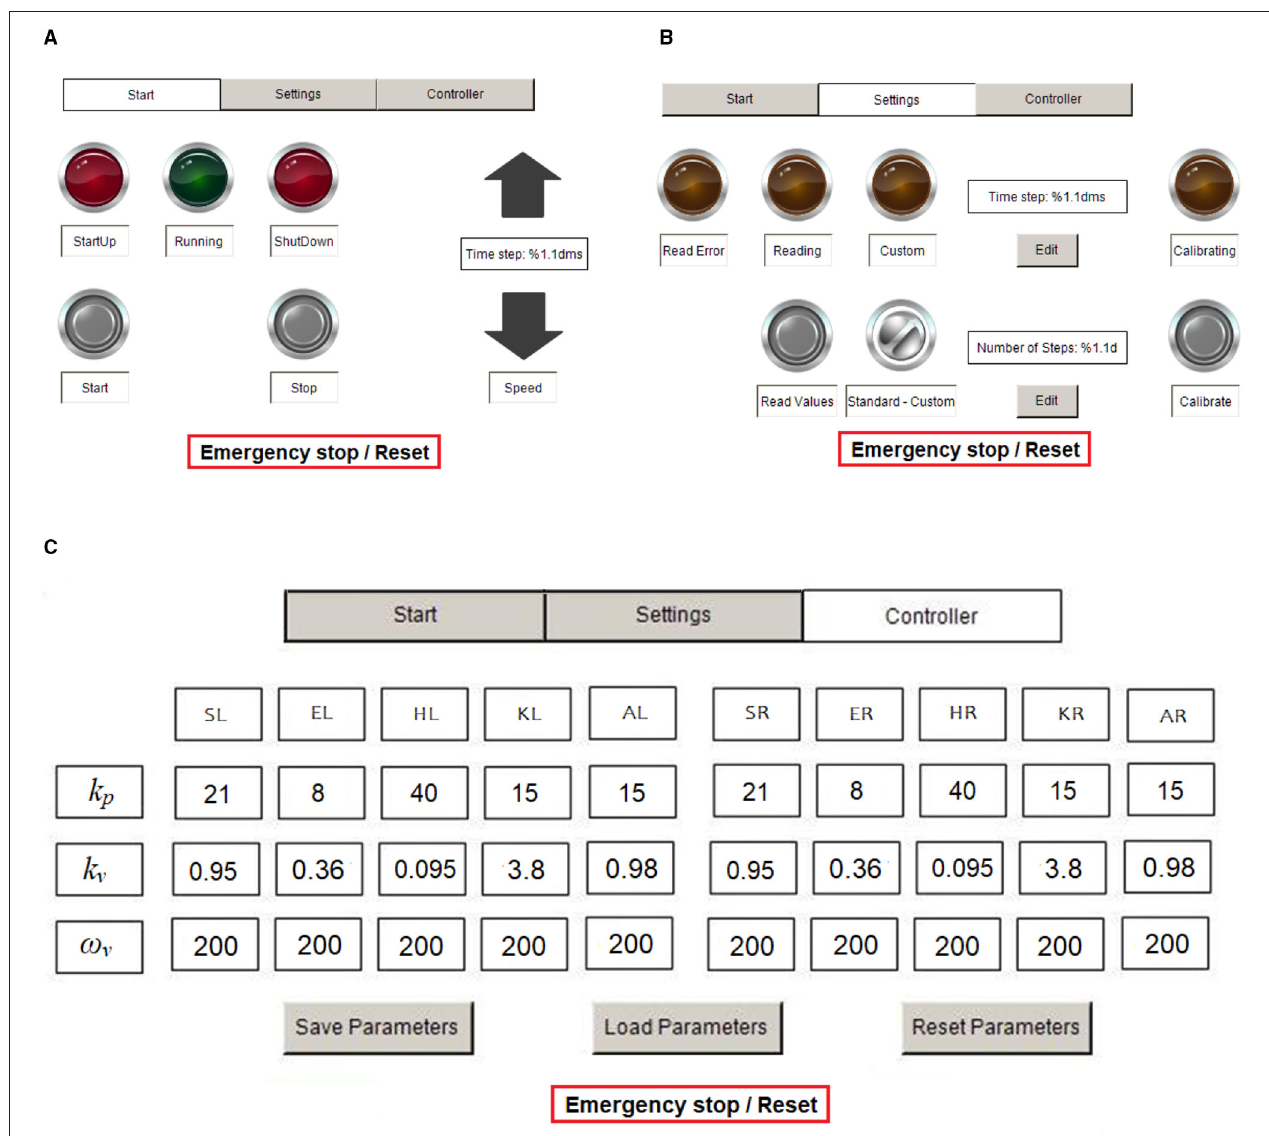
FIGURE 4 | HMI pages for operation. (A) Start page, (B) settings page, and (C) controller page. S, shoulder; E, elbow; H, hip; K, knee; A, ankle; R, right; and L, left.